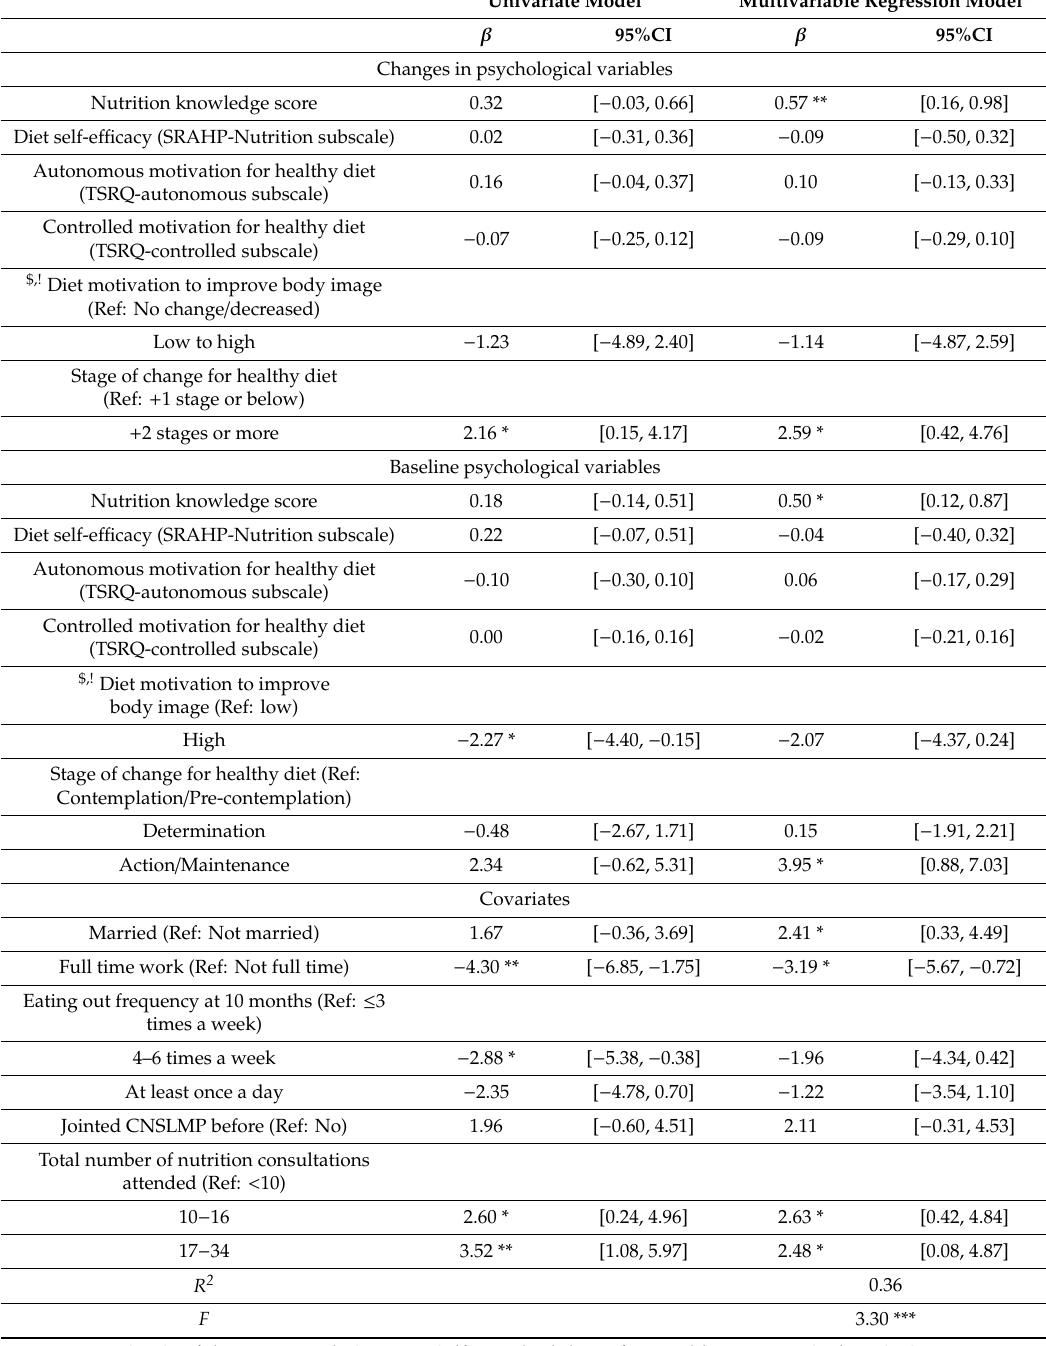
Table 3. Results of univariate and multivariable regression analyses for dietary adherence